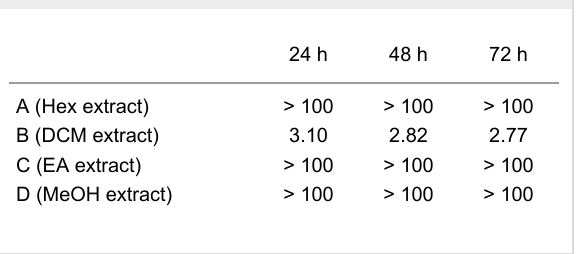
Table 1: Lethal concentration 50 ( μ g/mL) of extract A, B, C, and D after 24, 48 and 72 h.